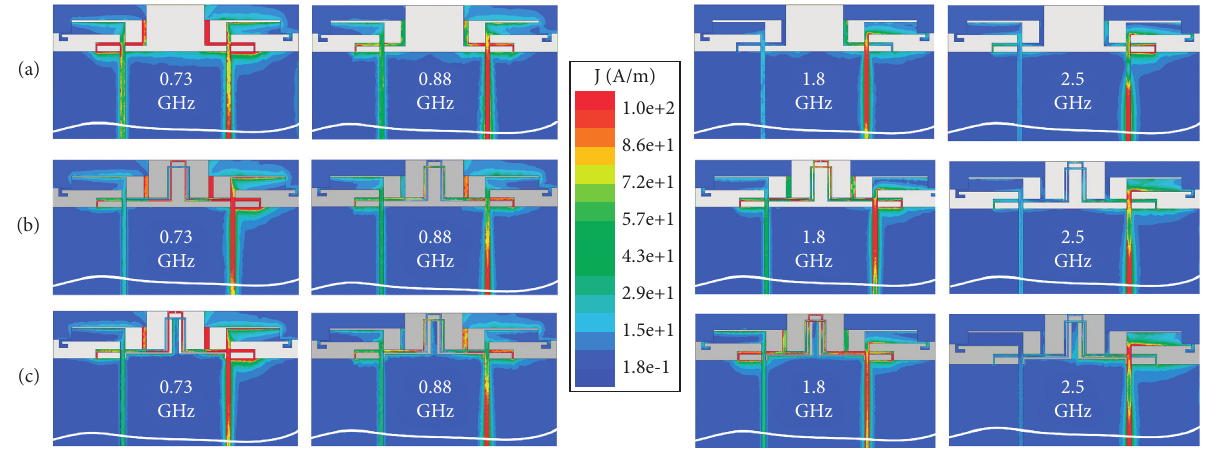
Figure 4: Scalar current distributions of Ant1, Ant2, and Proposed Ant at 0.73, 0.88, 1.8, and 2.5 GHz. (a) Ant1. (b) Ant2. (c) The Proposed